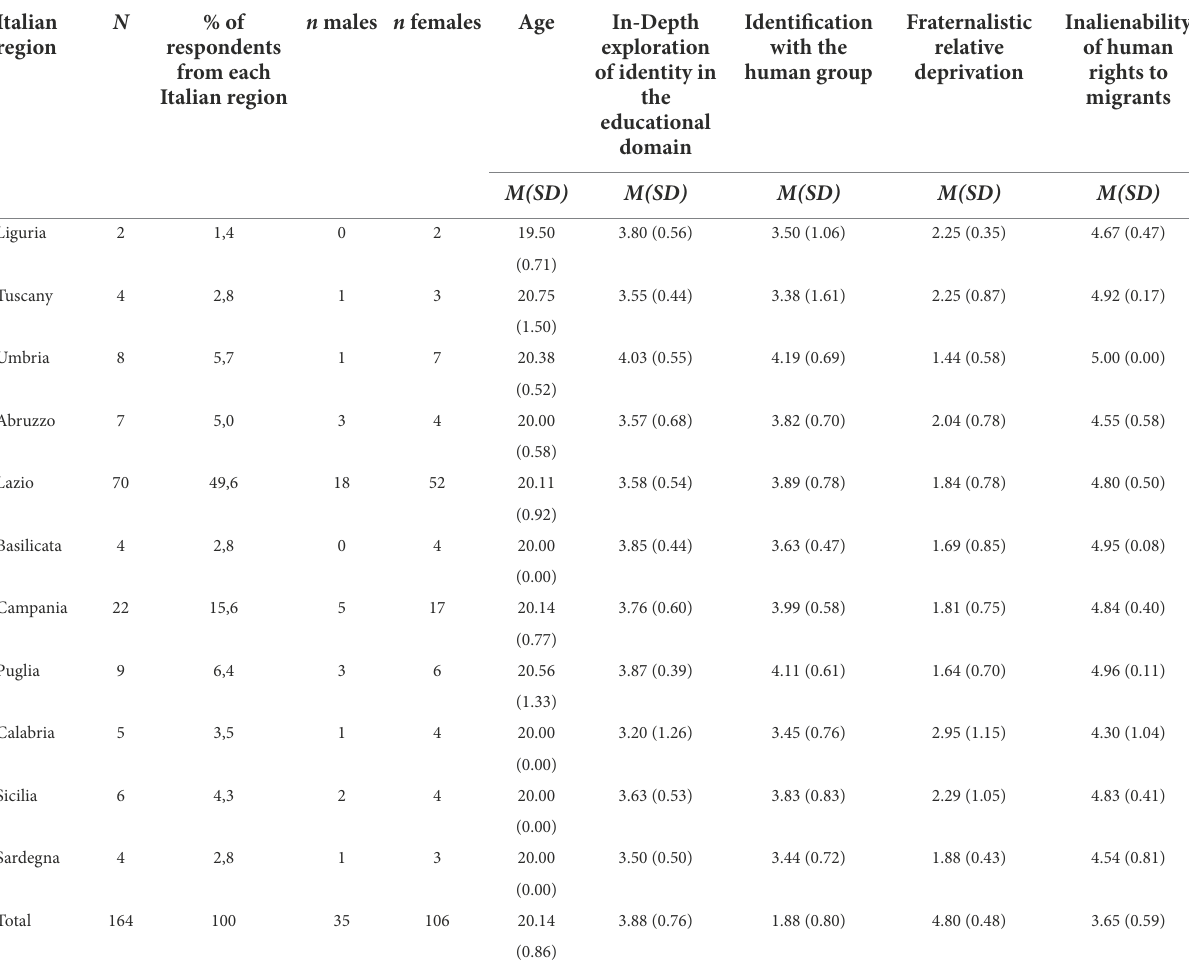
TABLE 1 Descriptive statistics for each Italian region. Italian region